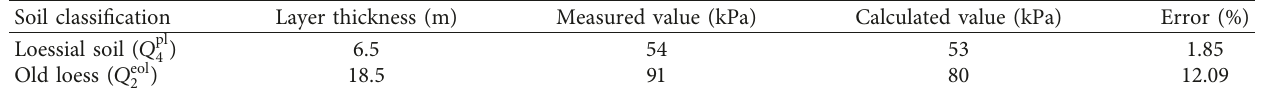
Table 5: Comparison of measured and calculated values of side friction.